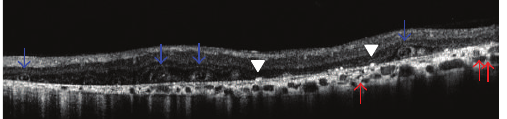
Figure 2: Case 2, left eye. Transvers SD-OCT section. Blue arrows: outer retinal tubulations alone or with high reflective spots within. White arrowheads: bright reflective spots on top of RPE-Bruch membrane complex. Red arrows: choroidal hyperreflective spots.